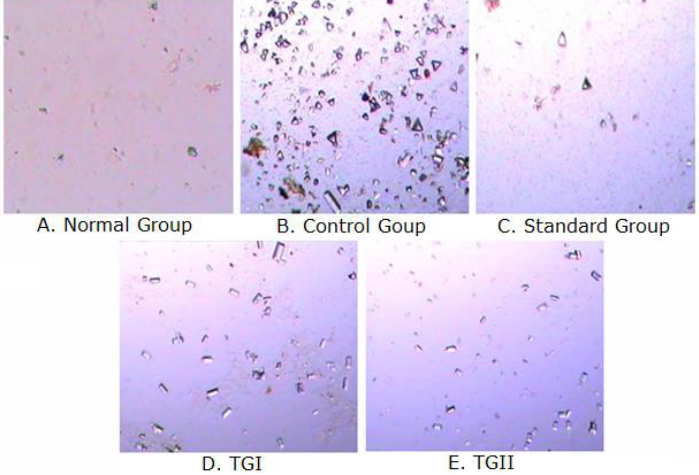
Figure 2. Microscopic observations of urine in various treatment groups. Table I. Effect of EETT on urine parameters in urolithiatic rats